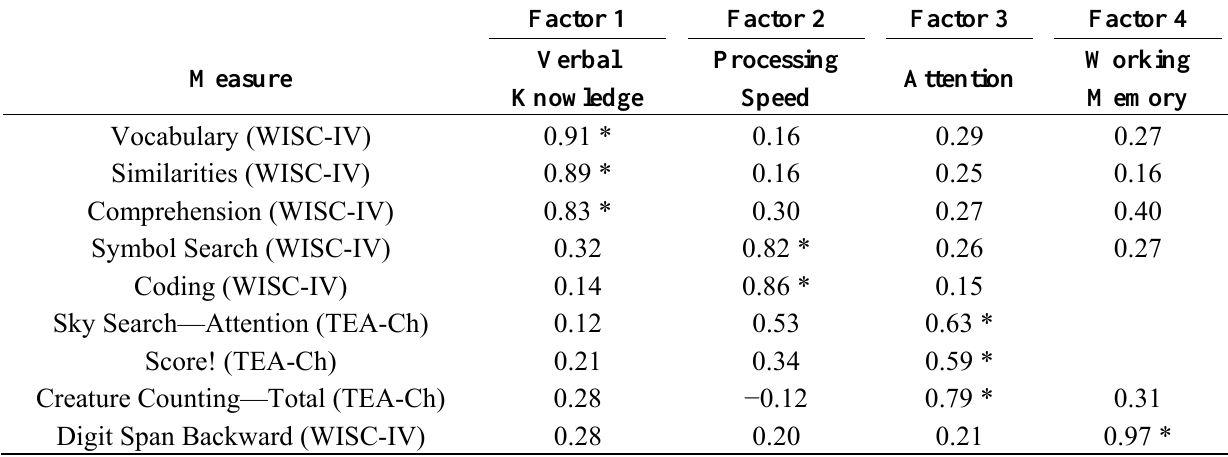
Table 3. Structure matrix of rotated factor loadings from exploratory factor